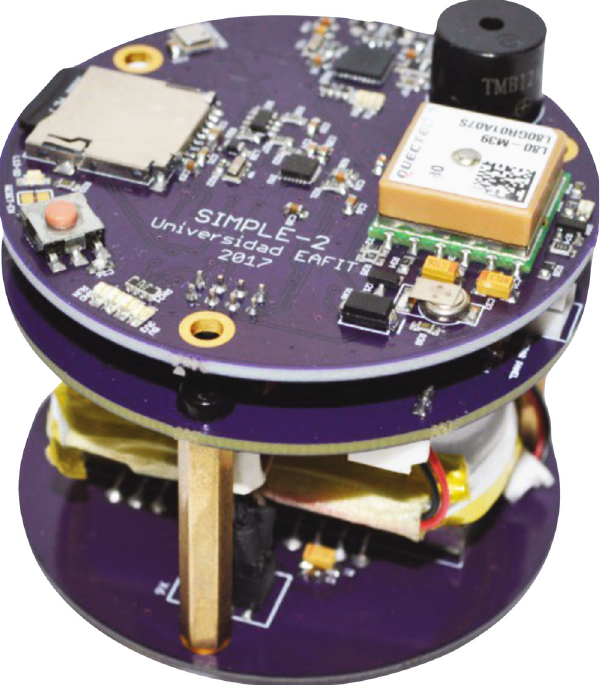
Figure 1: Prototype of CanSat Simple-2, which constitutes an experimental